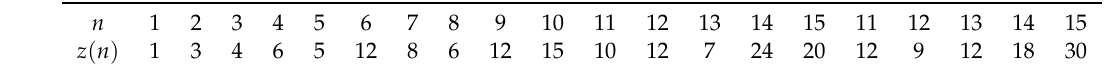
Table 1. Values of z ( n ) for 1 ≤ n ≤